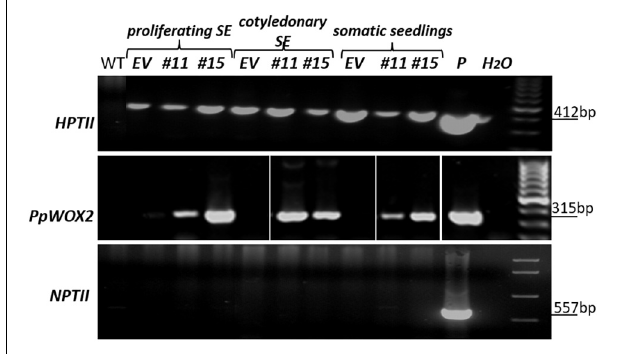
FIGURE 4 | PCR analyses to confirm the presence and stability of the transgene in 35S::PpWOX2 P. pinaster lines in various developmental steps from proliferating immature SEs to cotyledonary SEs and somatic seedlings. Lines #11 and #15 are PCR-positive (PCR+) throughout SE development. PCR amplification of HPTII (412 bp), PpWOX2 (315 bp), and NPTII (557 bp). Empty vector (EV): embryos of control line EV-pC05 transformed with pCAMBIA1305.2 , P = 35S::PpWOX2- isolated plasmid (positive PCR control). WT, wild-type, non-transgenic PN519 control line. H 2 O, negative PCR control (water as template).